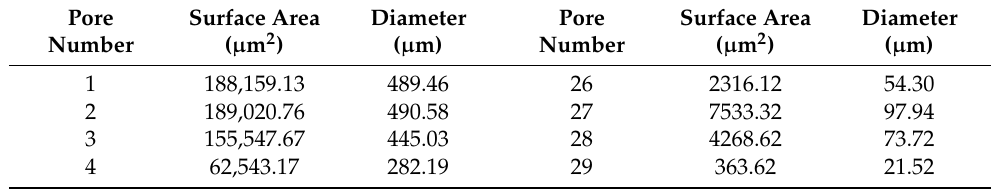
Table 4. Measurement results of pores extracted from SEM images for carbon sample